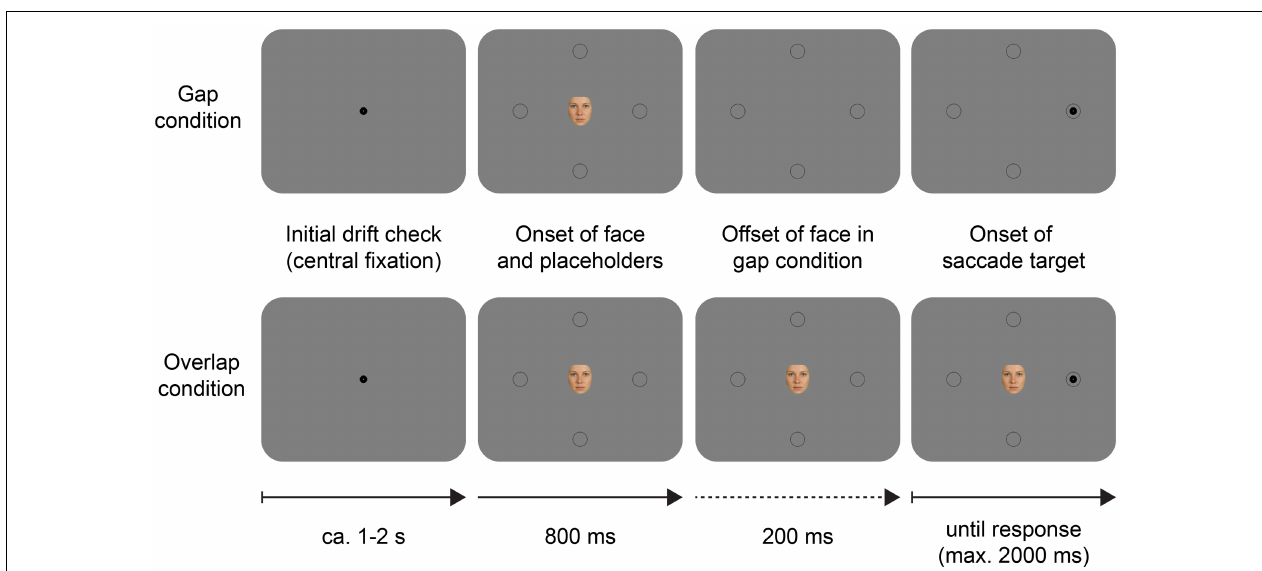
FIGURE 2 | Example schematic trials in the gap saccade task used in Experiment 1. The saccade target appeared randomly in one of the four placeholders around the central face stimulus. In the gap condition, the face